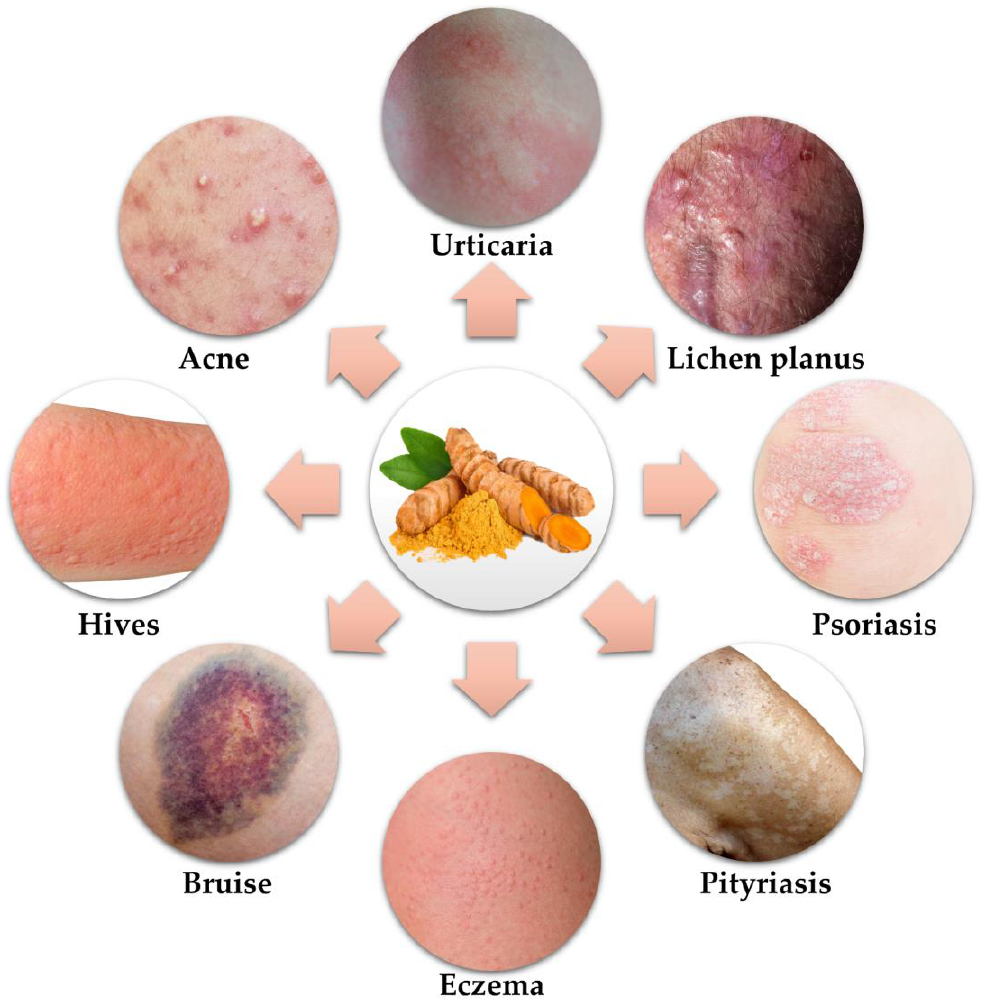
Figure 1. Potential of Curcumin in Skin Disorders. Created with BioRender.com (BioRender, Toronto, ON, Canada, accessed on 11 September 2022) .